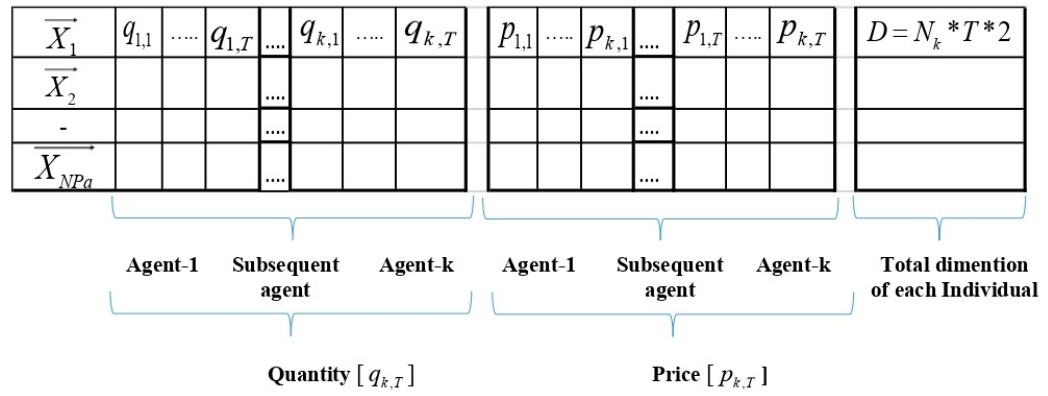
Figure 3. Representation of a solution (particle) in our algorithm.